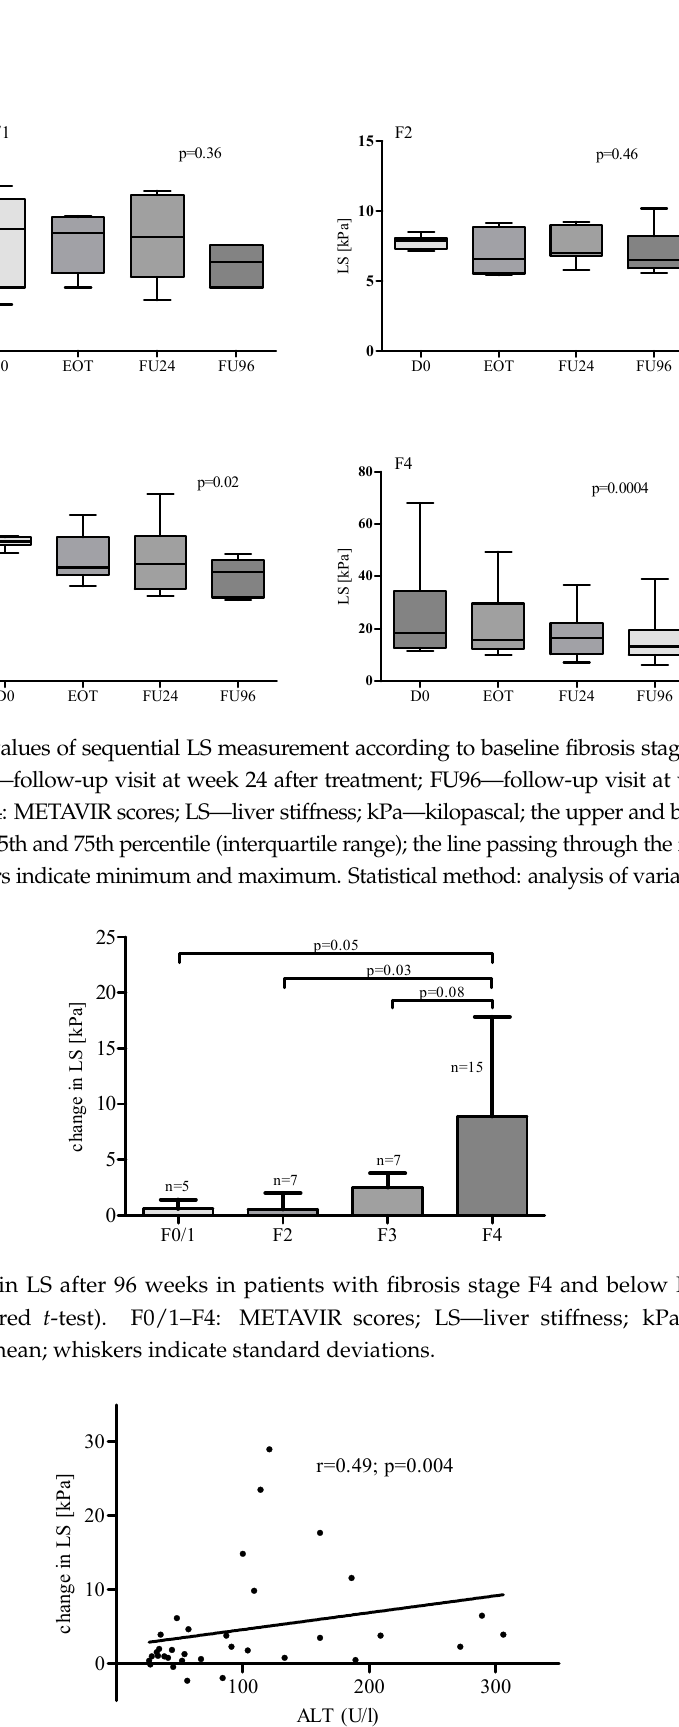
Figure 4. Correlation (Spearman’s rank correlation coefficient) between ALT activity at baseline and changes in LS between baseline and FU96. ALT—alanine aminotransferase; LS—liver stiffness; kPa— kilopascal.